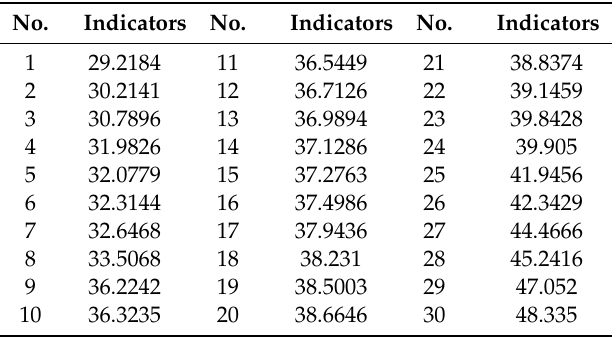
Table 1. The indicators of the top 30 best routes.